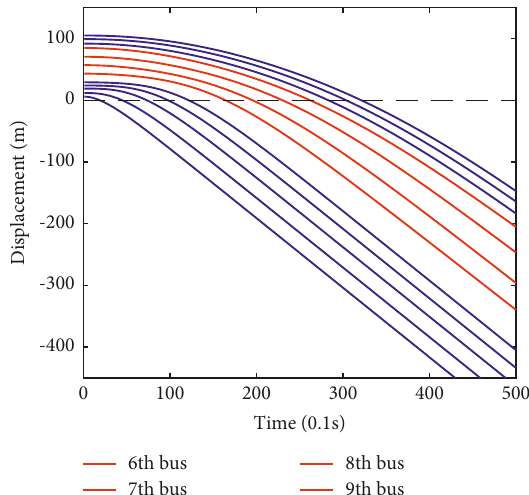
Figure 21: The numerical simulation diagram in 30–40% heavy vehicles scenario.